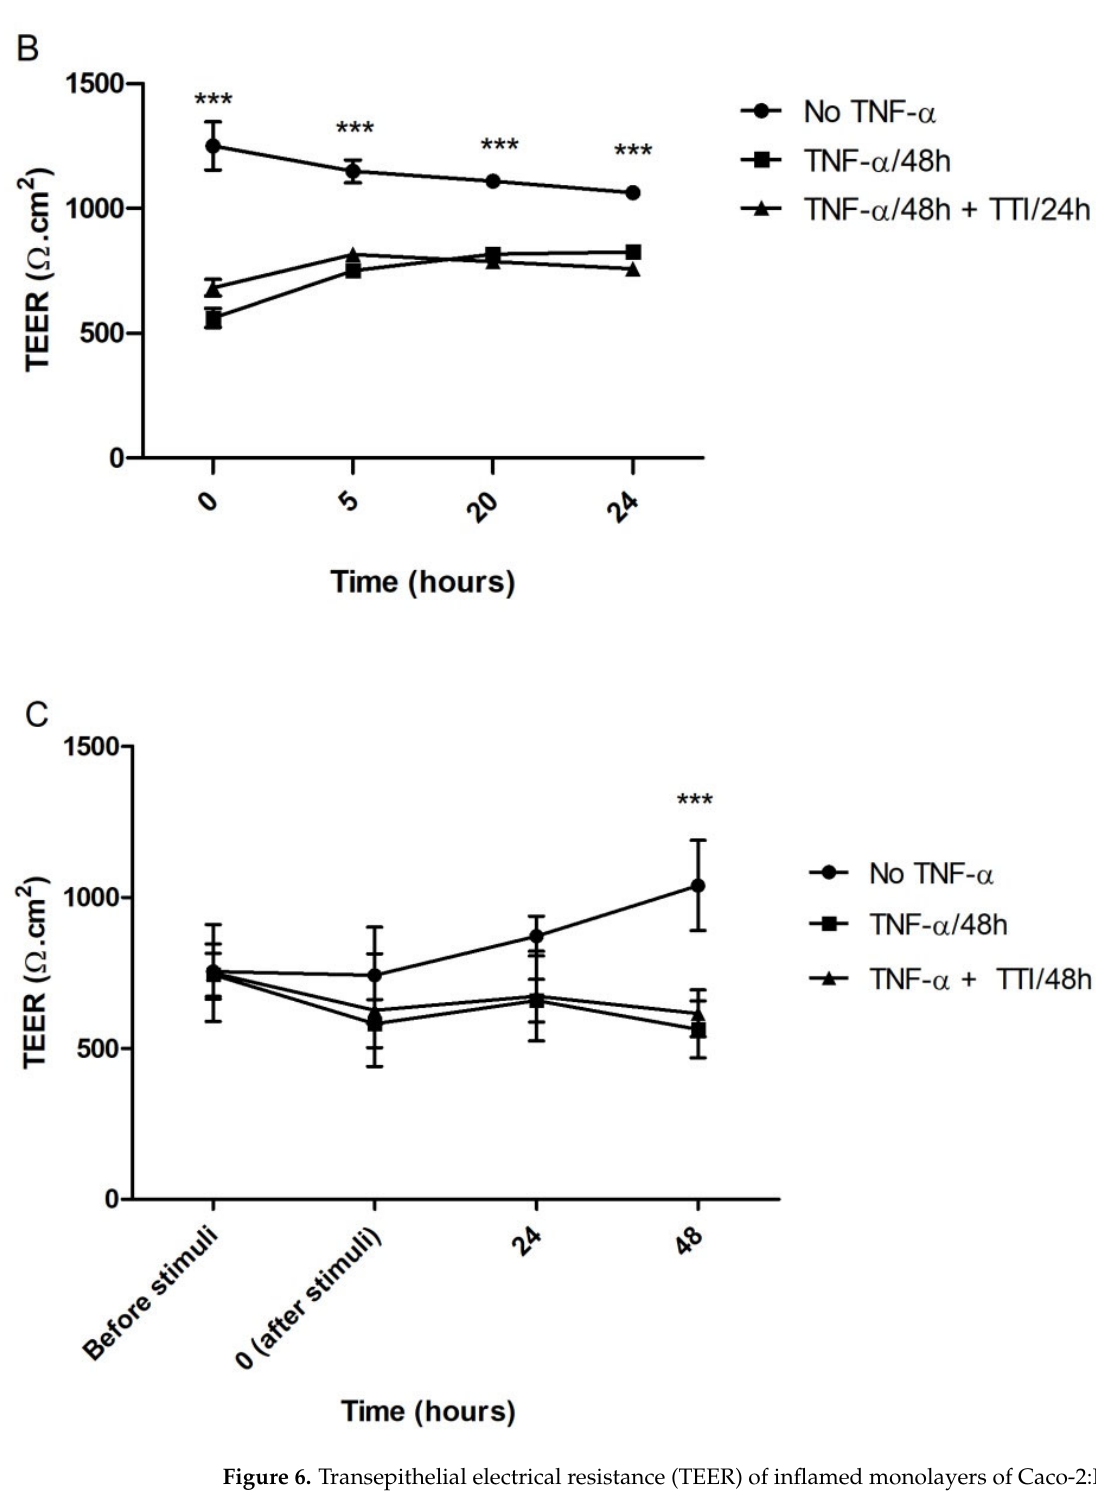
Figure 6. Transepithelial electrical resistance (TEER) of inflamed monolayers of Caco ‐ 2:HT29 ‐ MTX cells. ( A ) During induction of inflammation with TNF ‐α 50 ng/mL on the basolateral side, for 48 h. ( B ) During treatment with TTI 1.0 mg/mL for 24 h, on previously inflamed co ‐ cultures. ( C ) During treatment with TTI 1.0 mg/mL simultaneous to inflammation with TNF ‐α 50 ng/mL on the basolateral side, for 48 h. *** p < 0.001, in relation to the other groups (2 ‐ way ANOVA test with Bonferroni post ‐ hoc test). TNF ‐α : tumor necrosis factor alpha; TTI: trypsin inhibitor isolated from tamarind seeds.